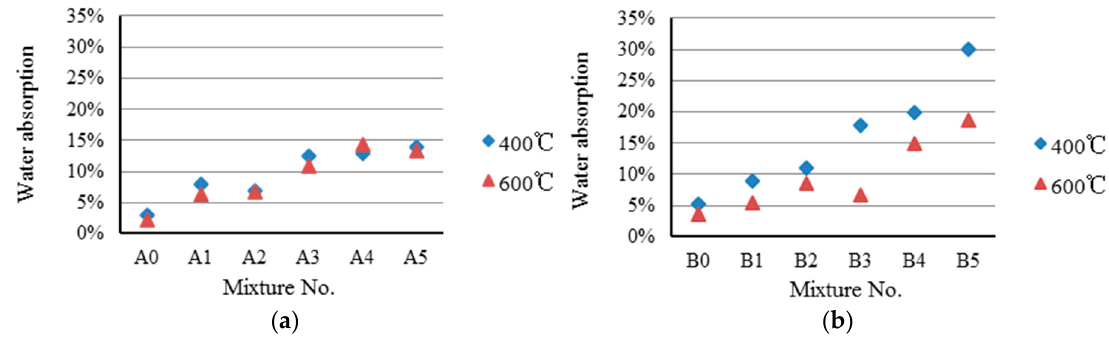
Figure 4. Water absorption of paper sludge lightweight aggregates. ( a ) A series; ( b ) B series.